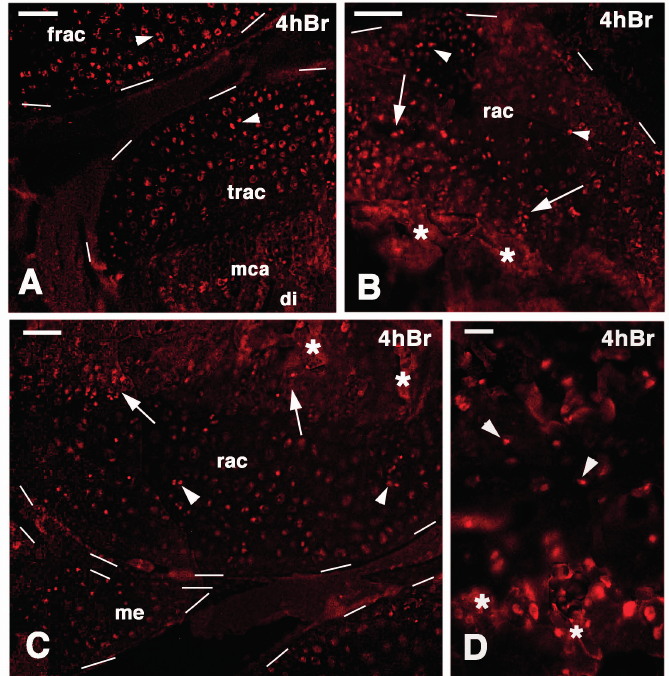
Figure 2. Immunofluorescence for TRITC for labeled cells in 21-day post-lesion knee epiphyses, four hours post-injection of 5Brdu. Dashes outline the cartilage surface. ( A ) sparse intensely labeled cells (arrowheads) are seen within the cartilaginous epiphyses. Bar, 50 µm; ( B ) detail on labeled cells (arrowheads) of the tibia epiphyses while labeled cells are also present in the serial cartilage (arrows) of the metaphyseal growth plate. Asterisks indicate some non-specific labeling of the mineralized matrix. Bar, 50 µm; ( C ) femur regenerated epiphyses containing inner labeled cells (arrowheads) and others labeled cells (arrows) are present in the serial cartilage of the metaphyseal growth plate and meniscus. Bar, 50 µm; ( D ) detail showing labeled cells (arrowheads) in the resting area of the forming metaphyseal growth plate. Asterisks indicate a non-specific labeling of the mineralized matrix Bar, 25 µm. Legends: frac, femur regenerated articular cartilage; me, meniscus; mca, metaphyseal articular cartilage; rac, regenerated articular cartilage; trac, tibia regenerated articular